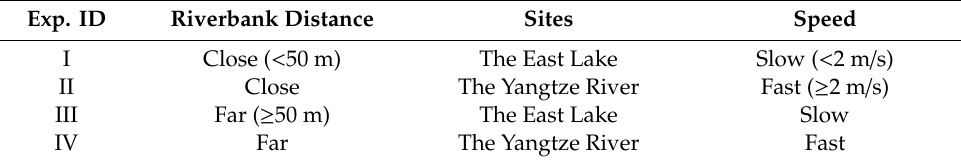
Figure 14. The WSL generation experiments for large scenes: ( a )–( e ) is experiment III in the East Lake, which is line segment extraction, line segment matching, line segment pool rough selection, line segment pool fine selection and the WSL generation. (f) – (j) is experiment IV, which is in the Yangtze River.